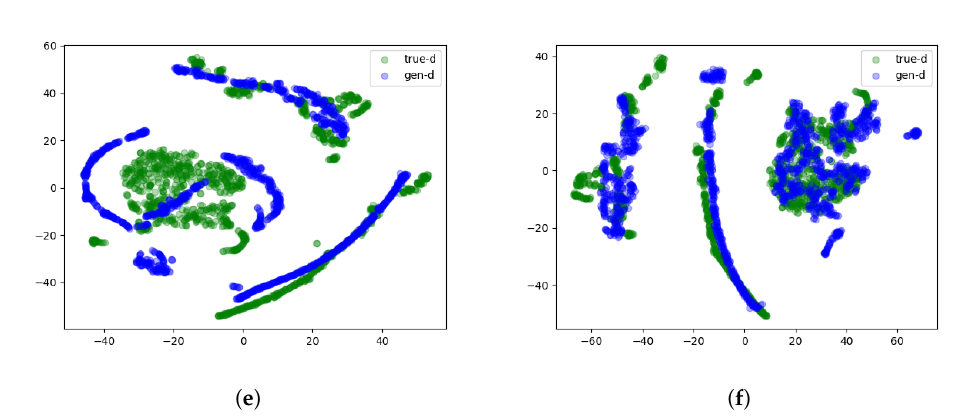
Figure 4. T-SNE plots of generated distributions and the ground truth distributions. ( a ), Summer to spring: ACDG generated OADC_FC fault data (SuSp4) v.s. ground truth OADC_FC fault